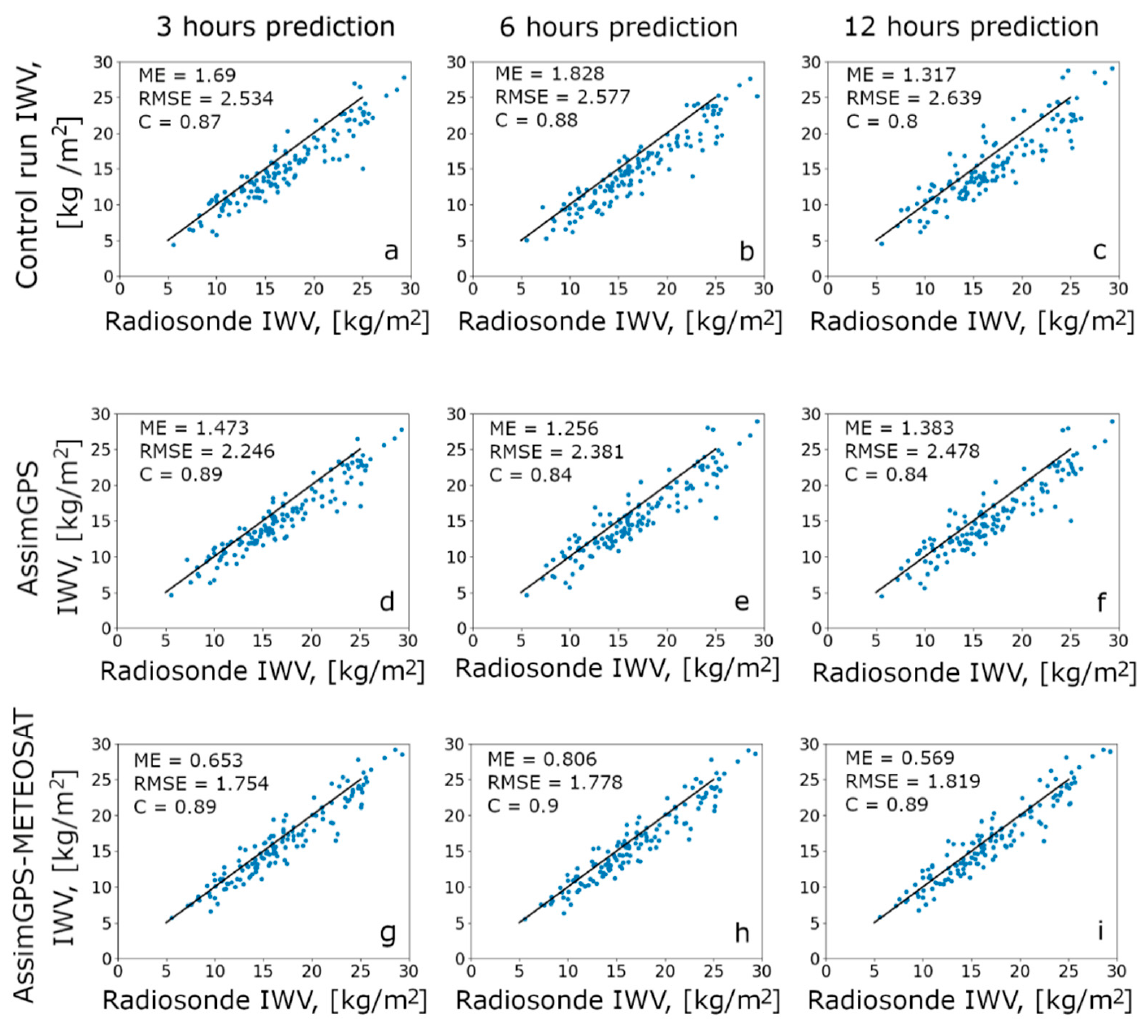
Figure 5. ( a – c ) Comparison of Control runs with radiosonde measurements for 3, 6, and 12 h, respectively. ( d – f ) Comparison of AssimGPS with radiosonde measurements for 3, 6, and 12 h, respectively. RMSE is reduced by ~6–11%. ( g – i ) Comparison of AssimGPS-METEOSAT with radiosonde measurements for 3, 6, and 12 h, respectively. RMSE is reduced by ~ 30%.